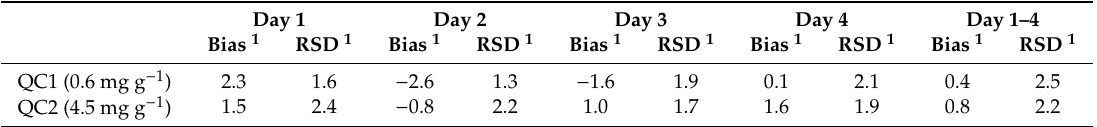
Table 3. Bias and relative standard deviation (RSD) values for determination of accuracy and precision.